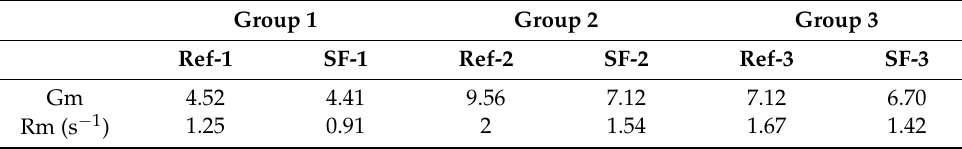
Table 3. Fresh properties of six SCM mixtures studied, reference (Ref) and seashell filler (SF).